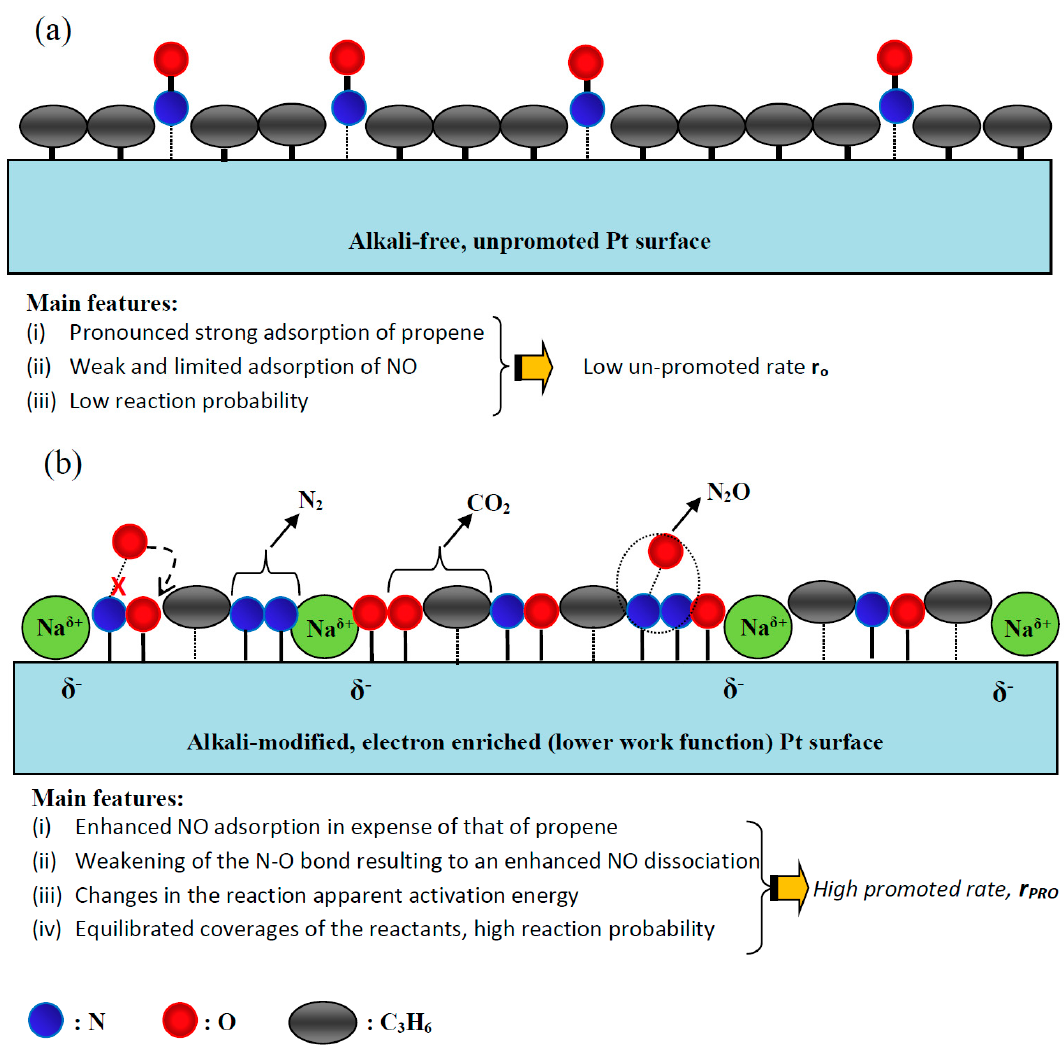
Figure 21. Schematic of the mechanism of action of alkalis as promoters on the Pt-catalysed NO + C 3 H 6 reaction. Expected distribution of reactants and/or intermediates over the unpromoted surface ( a ) and the Na-promoted surface ( b ).